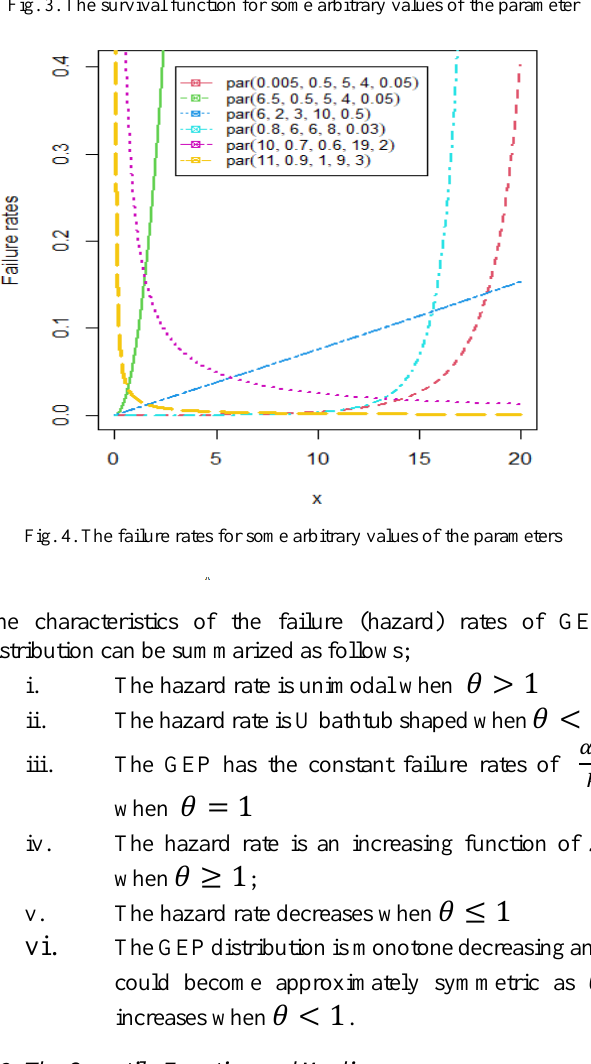
Fig. 3. The survival function for some arbitrary values of the parameter